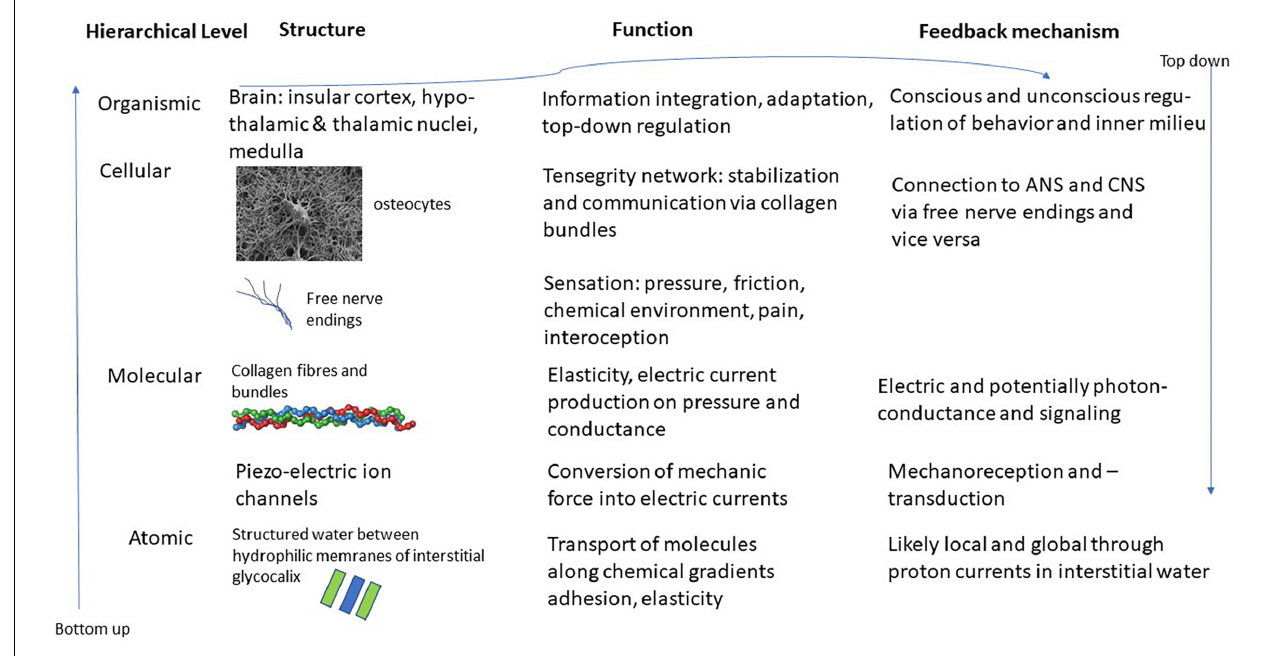
FIGURE 1 | Schematic representation of the various layers and structures of the interstitial matrix, connective tissue and fascia and potential interfaces with the ANS and CNS. Images of osteocyte and collagen bundle from